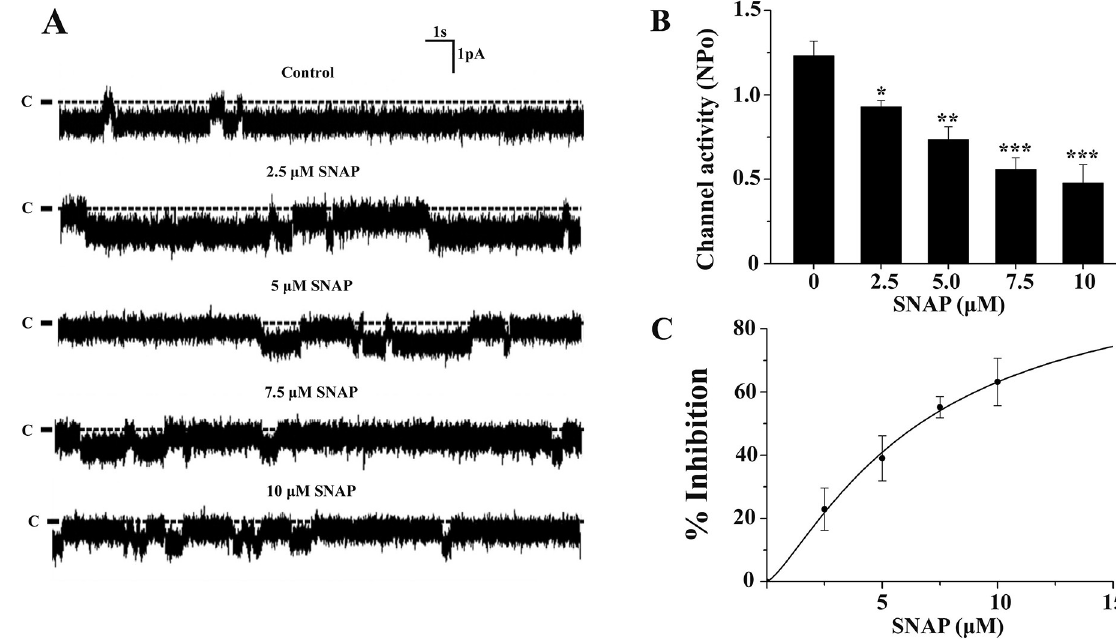
Fig 1. Inhibitory effect of SNAP on the basolateral 10-pS Cl - channel in the TAL. (A) Representative single channel traces of the basolateral 10-pS Cl - channel at a holding potential of -60 mV in the control and during successive exposure to different concentration of SNAP (2.5–10 μ M) from the same patch in cell-attached configuration. The channel closed level is indicated by the dotted line and “C”. (B) Statistical summary for dose-response effect of SNAP on the 10-pS Cl - channels from 5 sets of experiments. Each set of experiment was obtained by successive exposure to different concentration of SNAP (2.5–10 μ M) from the same patch. Asterisk indicates the significant difference between the control (no SNAP) and SNAP treated groups. ( * : P < 0.05, ** : P < 0.01, *** : P < 0.001, paired sample t-test). (C) The curve is the best fit to percentage of inhibition (Eq 3) against the [SNAP] according to the Hill equation (Eq 2) with IC 50 = 6.62 μ M.